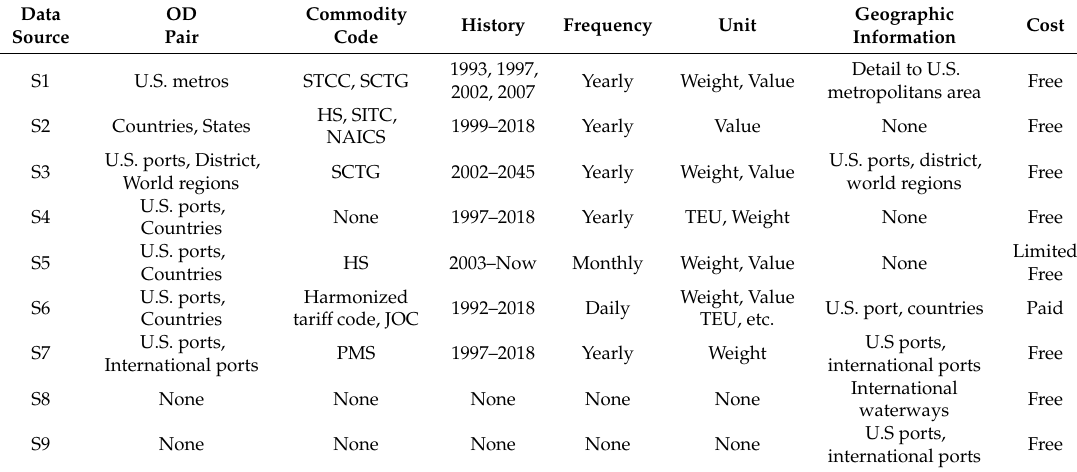
Table 1. Freight and port databases and